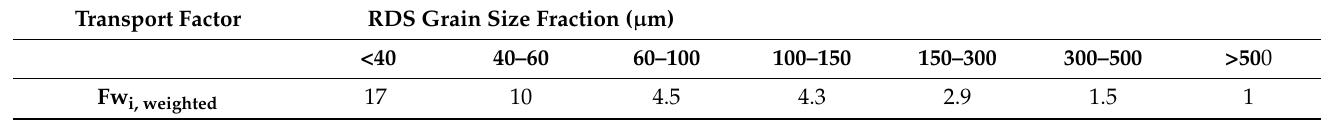
Table 2. Ratings of transport factors in RDS